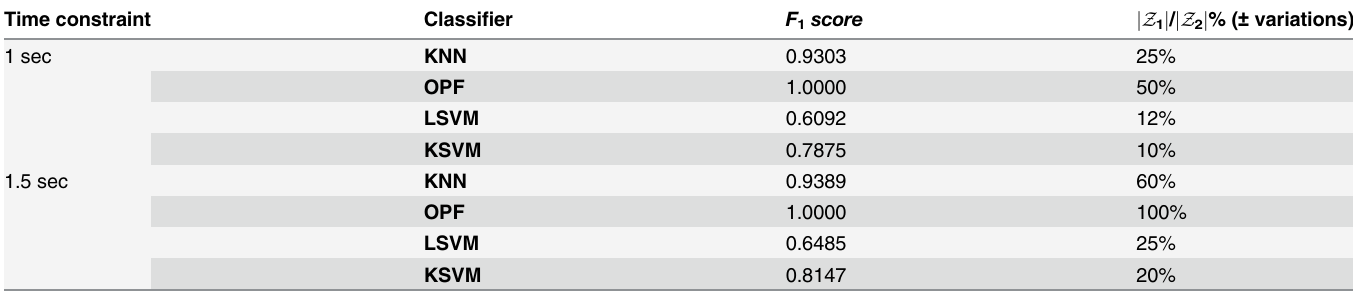
Table 12. Cone-Torus dataset: Predictivity performance over Z 3 and final training set size, j Z 1 j as a percentual of j Z 2 j , for each classification model using random selection and learning time constraint equals to 1 and 1.5 seconds. Time